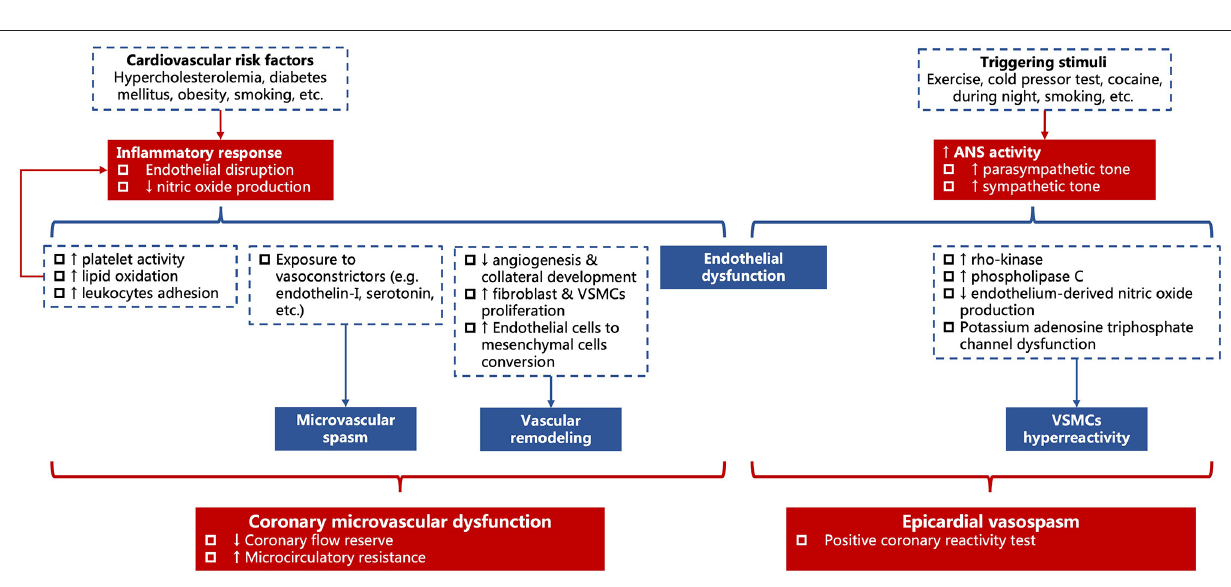
Endothelium, as discussed before, can release NO to induce vasodilation. Normally, vasoactive stimuli (e.g., acetylcholine, serotonin, and histamine) mediate vasodilation via endothelium- dependent release of vasodilators, especially NO. When endothelium bears significant damage, these vasoactive stimuli might directly act on VSMCs and cause paradoxical vasoconstriction ( Figure 2 ) (56,